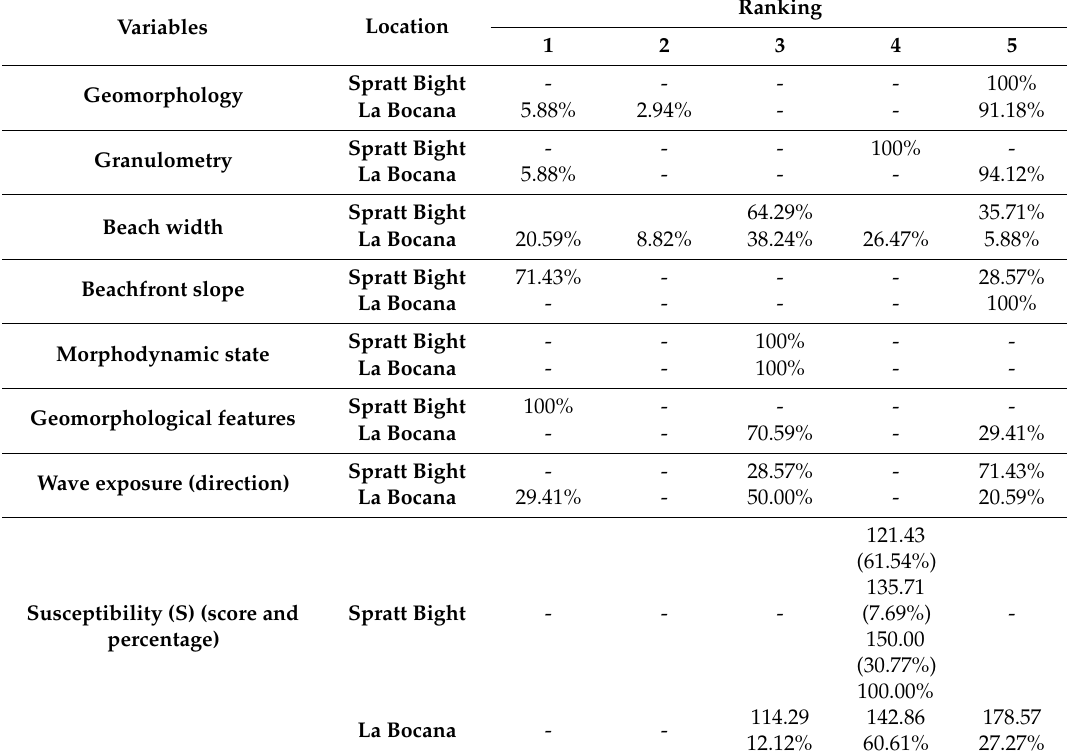
Table 6. Results of the susceptibility component of the coastal erosion hazard, by study area, ranking, and final score obtained. The percentage represents the number of segments on each ranking over the total number of segments.